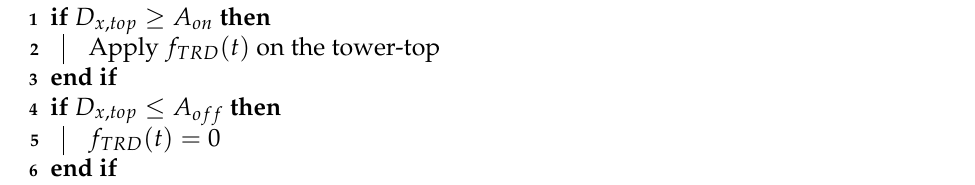
Algorithm 1: ON/OFF control of the TRD for the wind turbine tower.